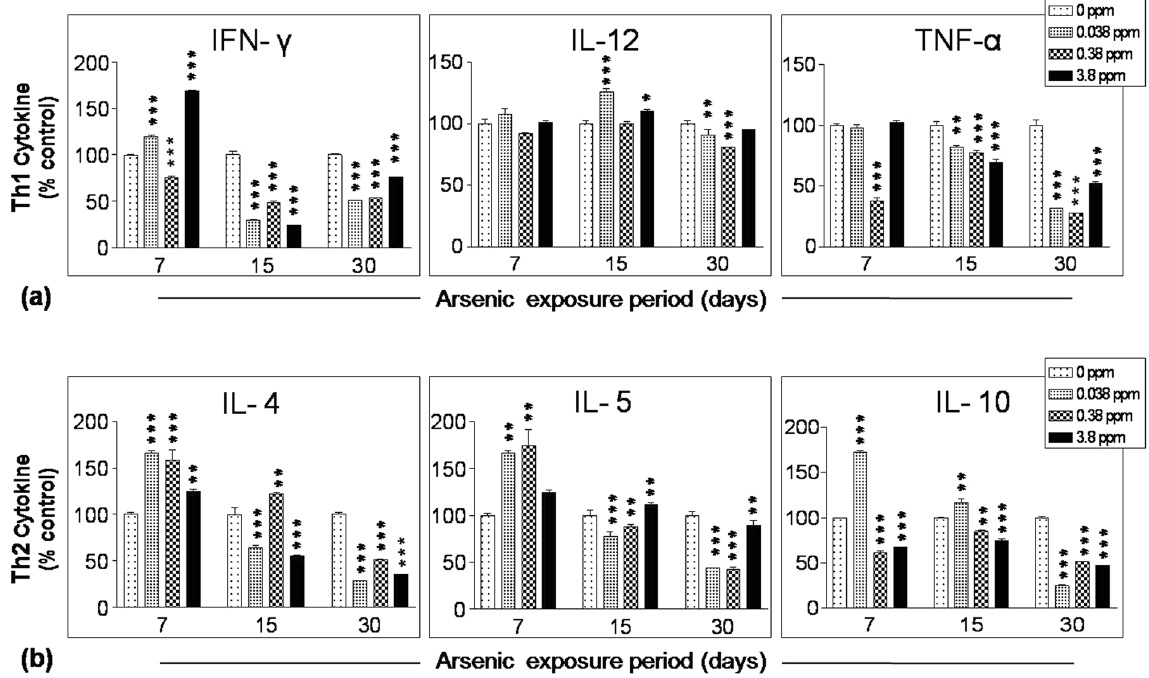
Figure 4. Effect of arsenic exposure on the mitogen induced splenic cytokine profile. Splenocytes (0.1 × 10 6 / 200 µ l/well) isolated from mice treated with arsenic (0.00, 0.038, 0.38 and 3.8 ppm) orally for 7, 15 and 30 days were incubated in 5% CO 2 incubator at 37 °C for 72 h in the presence or absence of ConA (2.5 µ g/ml). Levels of (a) T h 1 (IFN- γ , IL-12 and TNF- α ) and (b) T h 2 (IL-4, IL-5 and IL-10) related cytokines in splenocytes culture supernatant was estimated; plated in triplicate from pooled samples of each treatment group. Fluorescence associated with different antibody-coated magnetic beads was read under Bio-Plex MAGPIX multiplex reader. The cytokine levels are expressed as percent of control. Values are mean ± S.E. (n = 3 per group). * p < 0.05, ** p < 0.01 and *** p < 0.001 compared to